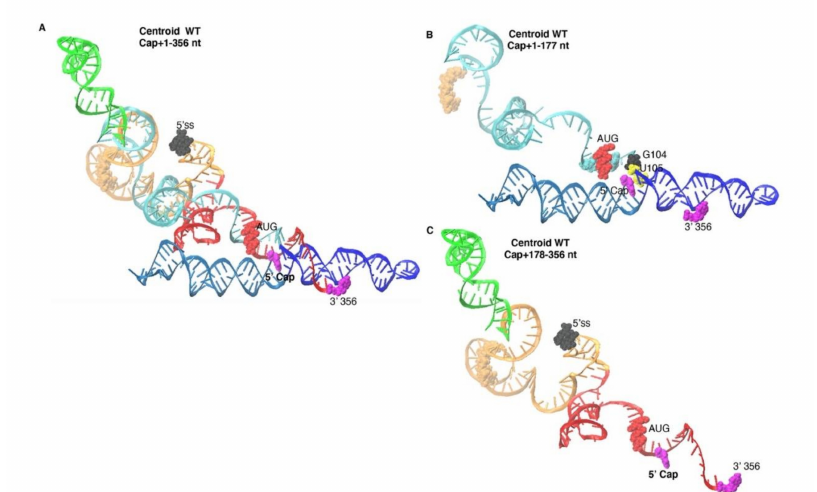
Figure 8. Output of Centroid WT predicted U5-AUG pairing and apical position of 5 (cid:48) ss. ( A ) 3D model predicted by SimRNA based on Centroid WT theoretical input constraints. ( B ) Focus on 5 (cid:48) -Cap + 1–177. ( C ) Focus on nt 178–356. Colors designate: TAR, light blue; PolyA, navy; U5 stem, cyan; PBS-segment, green; DIS stem and 3-way junction, orange; AUG stem, red; 5 (cid:48) -splice site (5 (cid:48) ss), black. Space filling atoms: 5 (cid:48) -Cap and 3 (cid:48) terminus, magenta; G104, yellow, U105, black, AUG translation start codon, red.